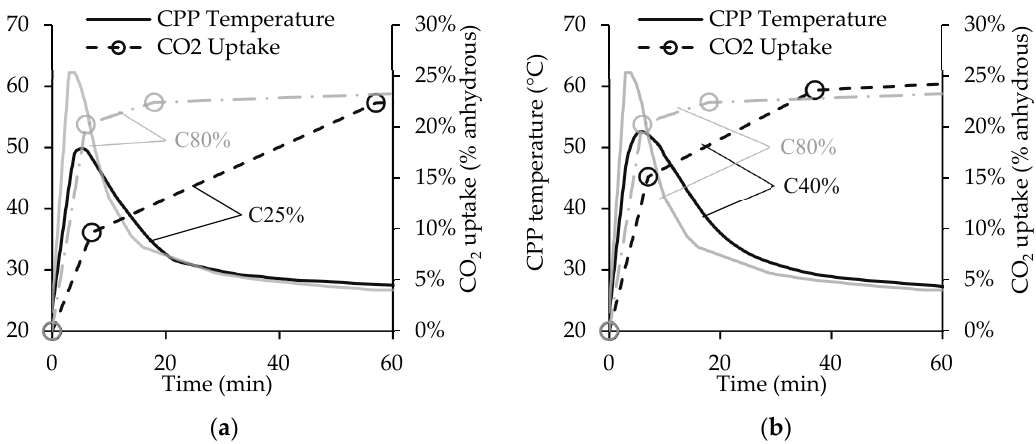
Figure 4. CO 2 uptake and temperature for 25% and 40% CO 2 concentration. Comparison between C25% and C80% ( a ) and between C40% and C80% ( b ).